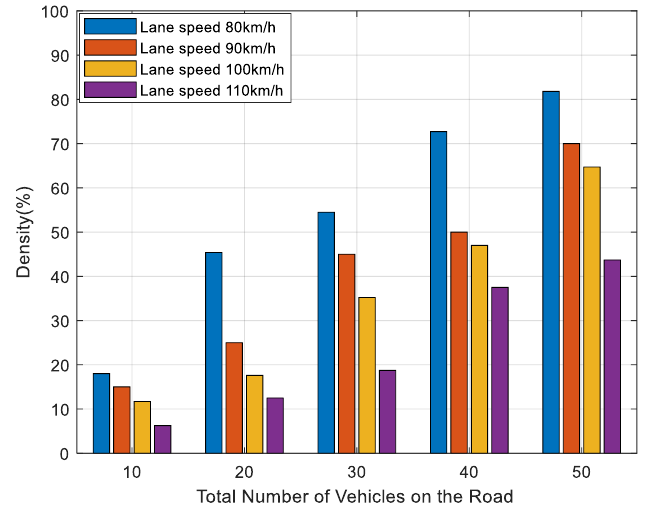
Figure 10. Percentage of density.